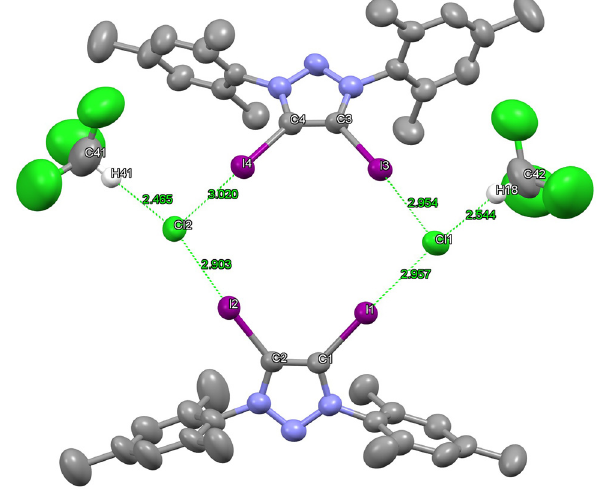
Table  : Data collection and